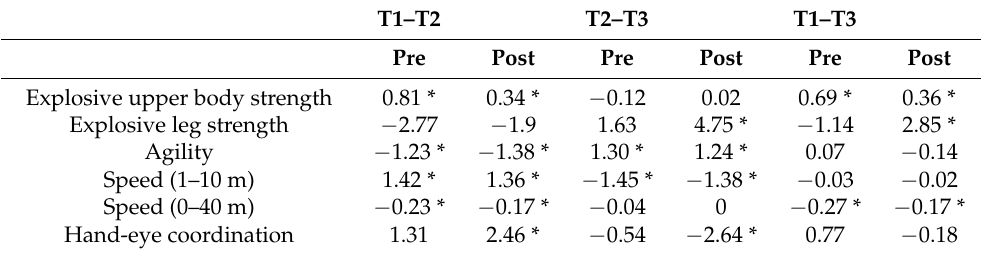
Table 4. Significance of changes in motor fitness characteristics of pre- and post-menarche groups.